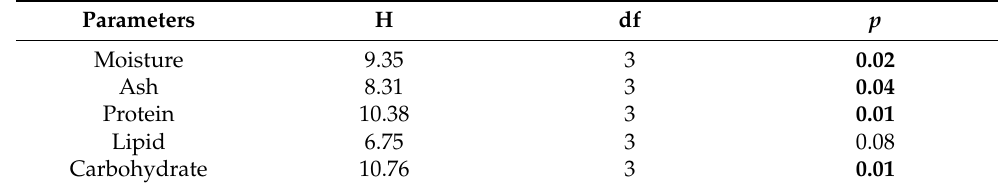
Table 1. Seasonal changes in proximate composition of A. opercularis during the study period. Val- ues are mean ± S.D. ( n = 3).